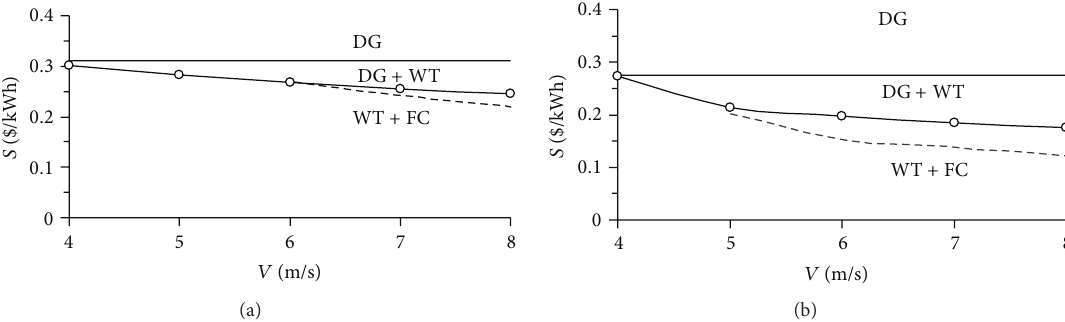
Figure 9: Electricity cost for the scheme in Figure 3 at a fuel price of $1100/toe and with the load power of 50kW (a) and 1000kW (b) and prospective indices of electrolyzers, hydrogen tanks, and fuel cells. 𝑉 is the average wind speed at a height of 10m, 𝑝 is the diesel price, DG is the diesel generator, WT are the wind turbines, and FC are the fuel